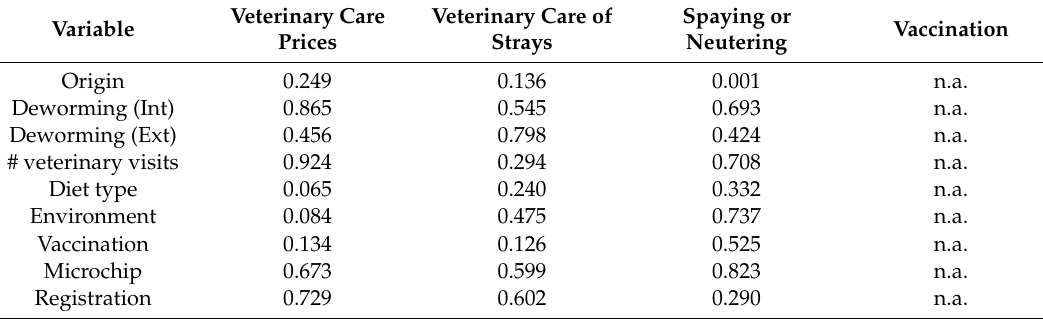
Table A3. Likelihood ratios between opinions of owners and other